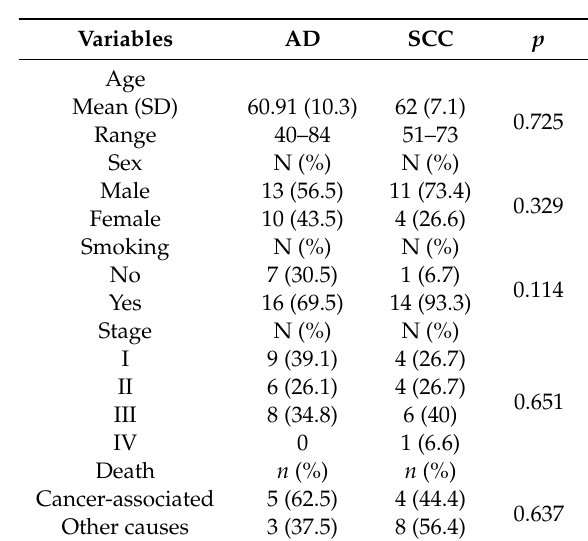
Table 1. Demographic and clinicopathological data of patients with lung adenocarcinoma (AD) and squamous cell carcinoma